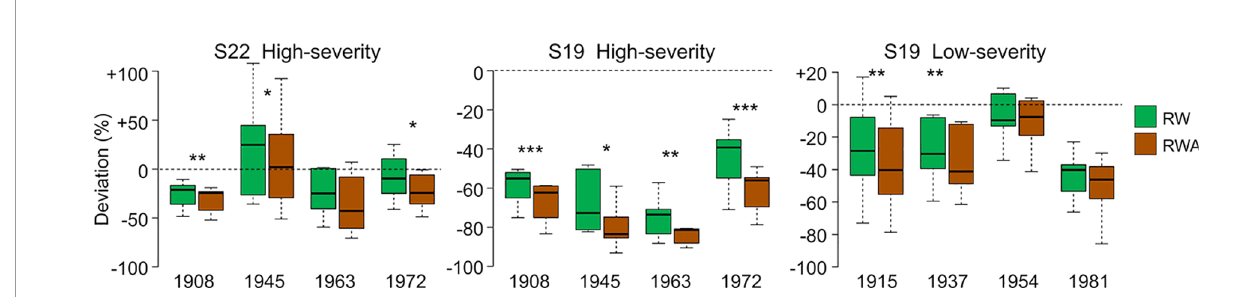
FIGURE 5 | RW and RWA deviations from reference during the fi rst year of outbreaks at S22 and S19. Deviation is the percentage variation of the parameter during the fi rst year of each outbreak from the reference, i.e. the mean value in the fi ve years before the outbreak. Each box represents median, interquartile range (IQR), minimum and maximum deviation from the reference. Asterisks indicate signi fi cant difference between RW and RWA deviation within the same year at p < 0.05 (*), p < 0.01 (**), and p < 0.001 (***), according to paired Welch ’ s t-test. Dashed lines indicate deviation equal to